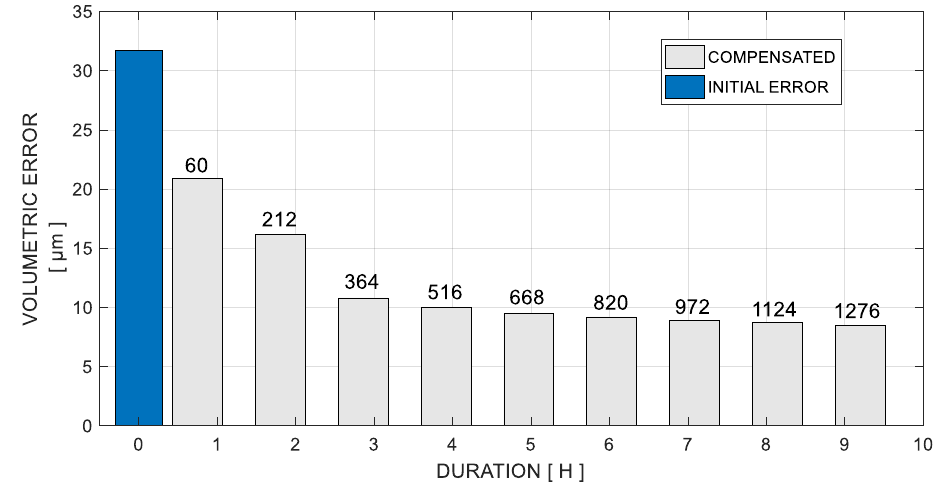
Figure 6. Simulation results with increasing measured points. Total number of points is shown, as well as the initial (blue) and compensated (grey)